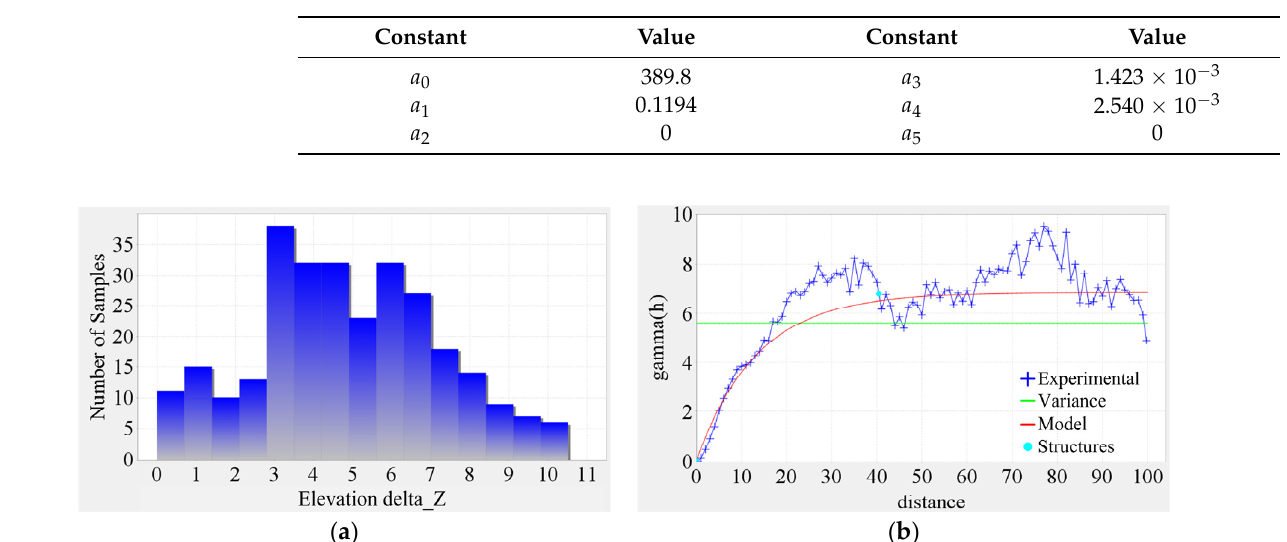
Figure 9. ( a ) Histogram and ( b ) experimental semivariogram of transformed elevation data.